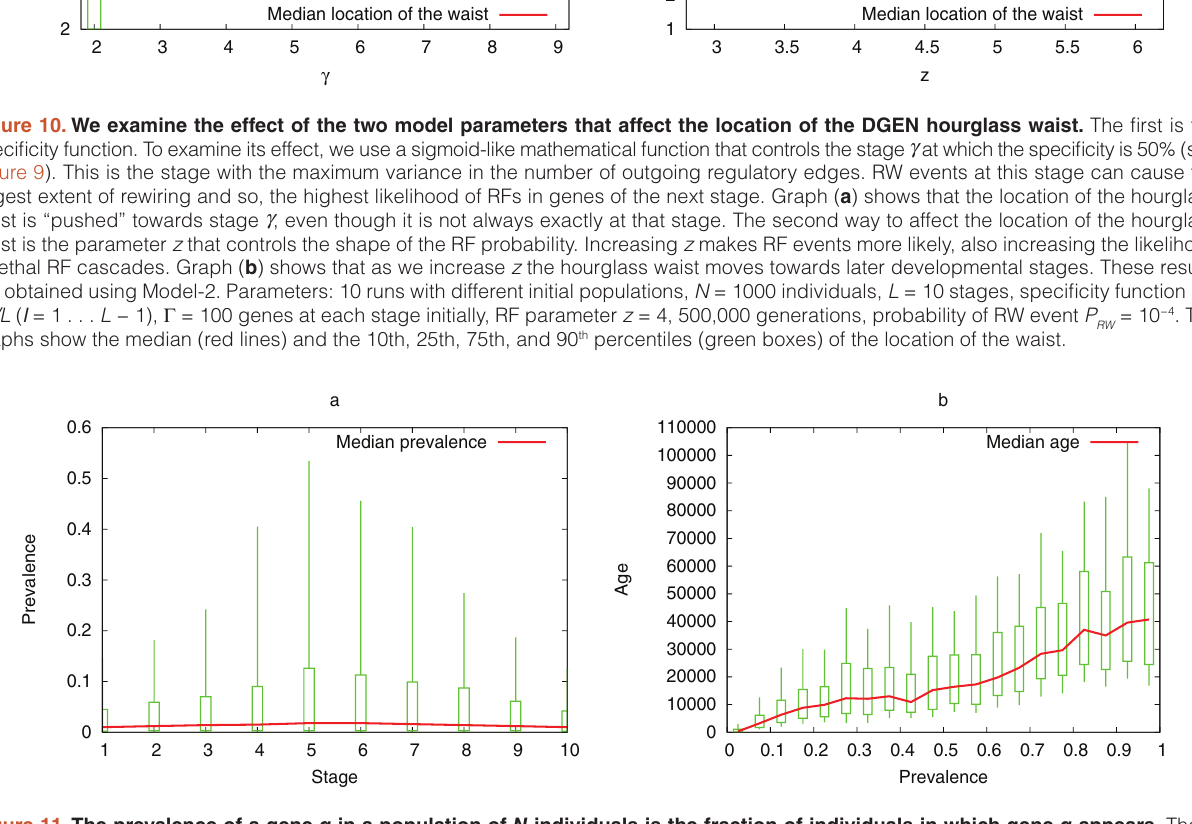
Figure 11. The prevalence of a gene g in a population of N individuals is the fraction of individuals in which gene g appears. These results are obtained using Model-2. Parameters: 10 runs with different initial populations, N = 1000 individuals, L = 10 stages, specificity function s ( l ) = l / L ( l = 1 . . . L −1), Γ = 100 genes at each stage initially, RF parameter z = 4, 500,000 generations, probability of RW event P = 10 −4 . The graphs show the median (red lines) and the 10th, 25th, 75th, and 90th percentiles (green boxes) for: ( a ) prevalence of genes RW in each stage after 500,000 generations, and ( b ) gene age as a function of gene prevalence. As expected, older genes tend to be more prevalent in the